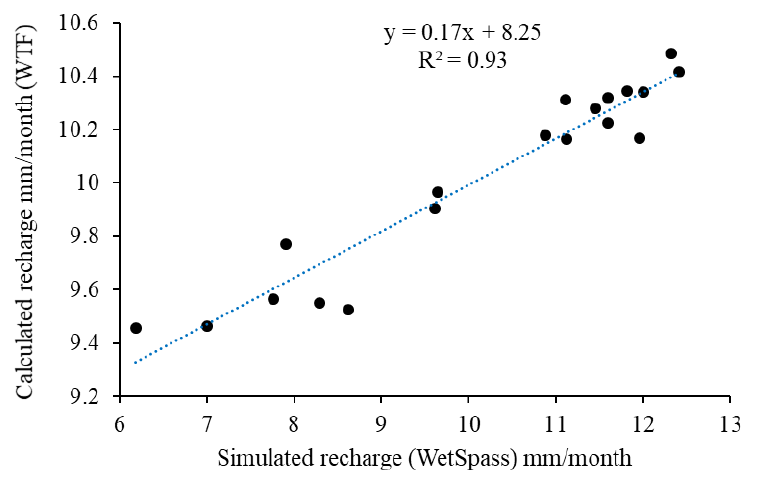
Figure 8. The linear relationship between simulated and observed groundwater recharge.